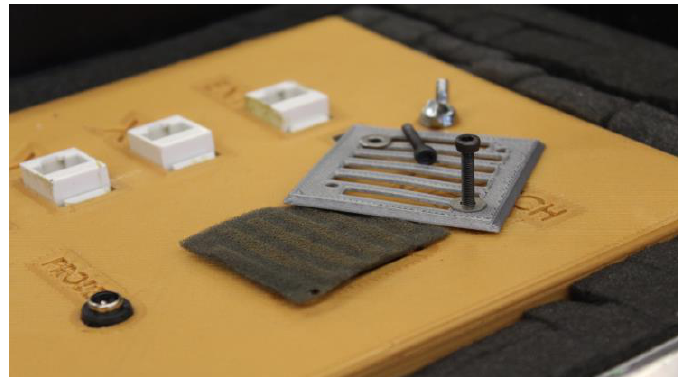
Figure 10. Fans with dust filters were effective at protecting electronics.